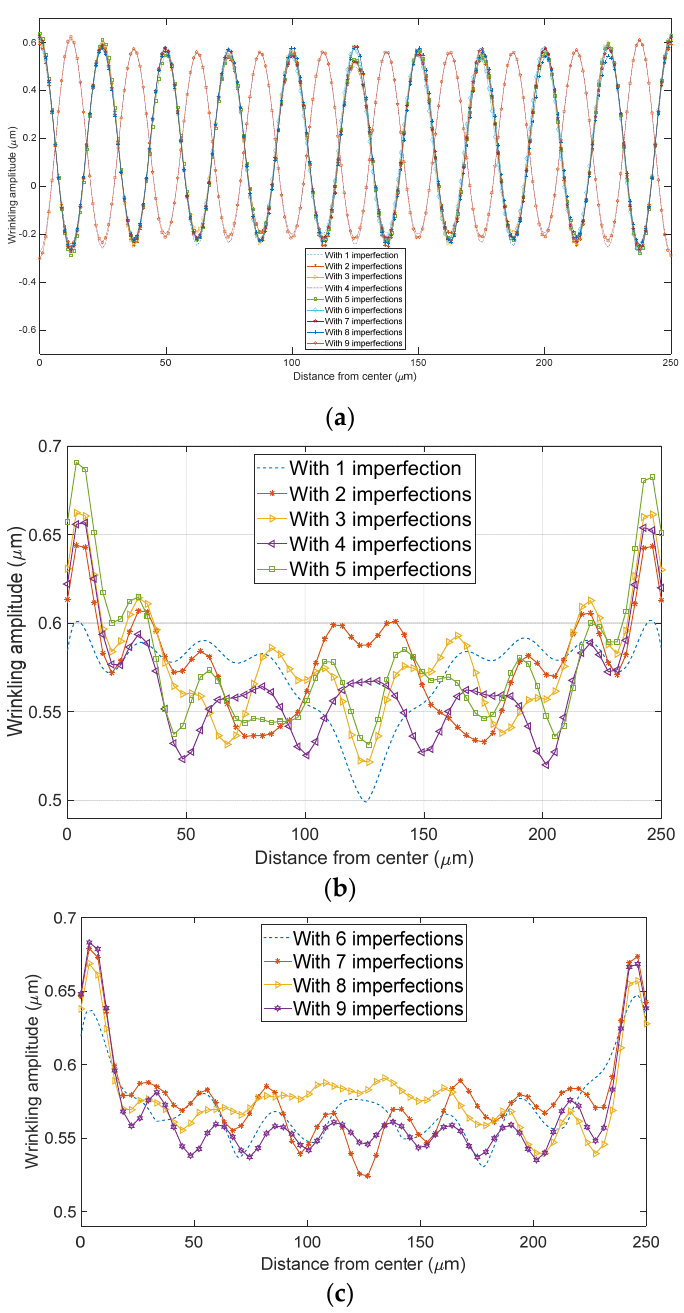
Figure 4. Wrinkling pattern as function of the number of imperfections. ( a ) Sinusoidal wrinkling pa tt ern; ( b ) Envelope of the wrinkling pa tt ern 1; ( c ) Envelope of the wrinkling pa tt ern 2.